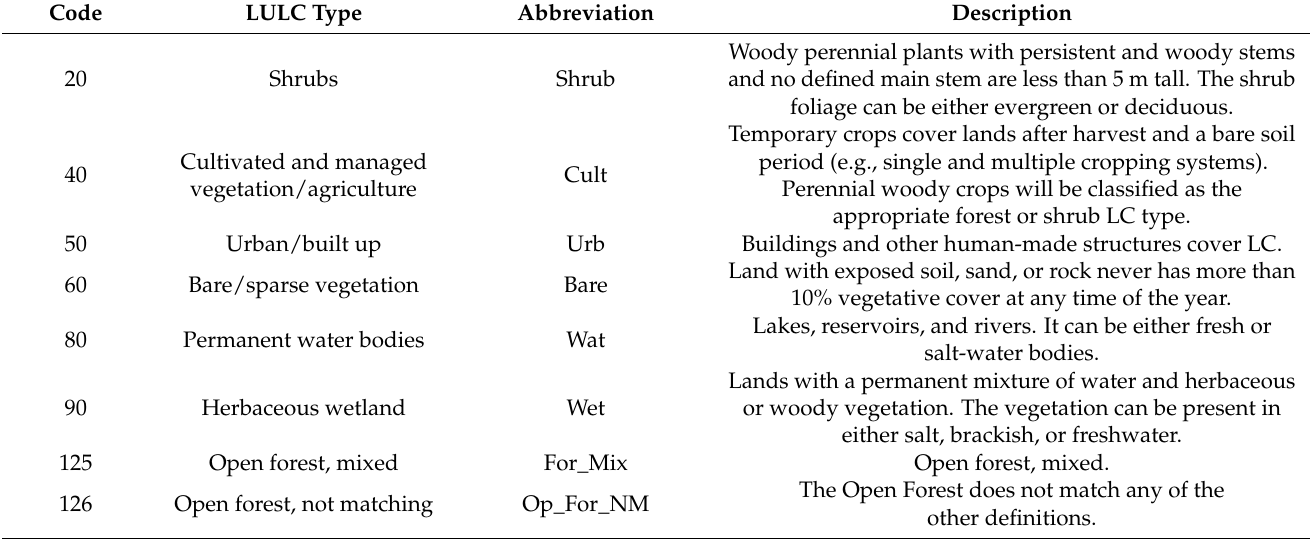
Table 2. Proposed LULC classification scheme and the corresponding